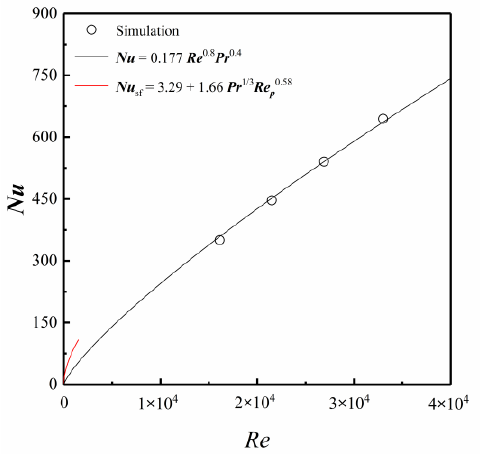
Figure 12. Correlation of the Nusselt number and comparison with other correlations.